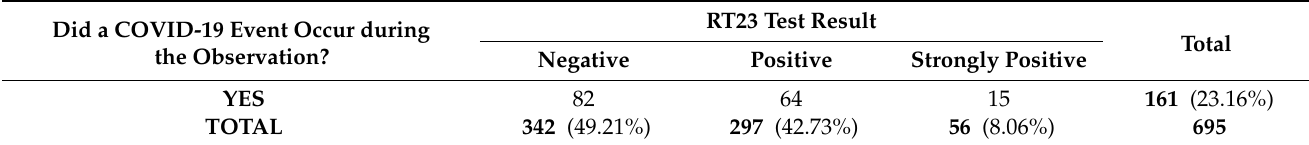
Table 12. The number of COVID-19 incidents depending on the result of the RT23 test.